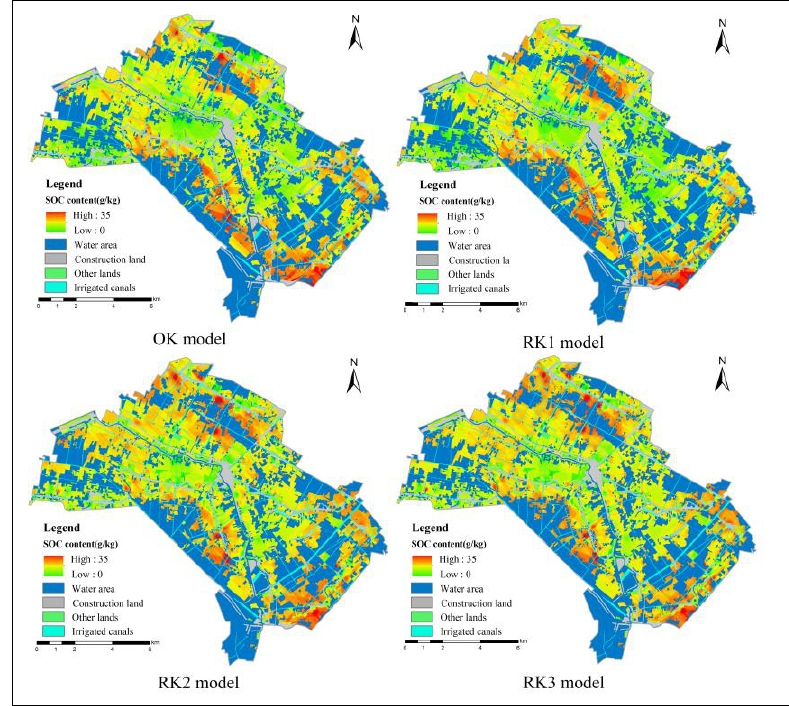
Figure 3.Maps of SOC content estimated by four spatial